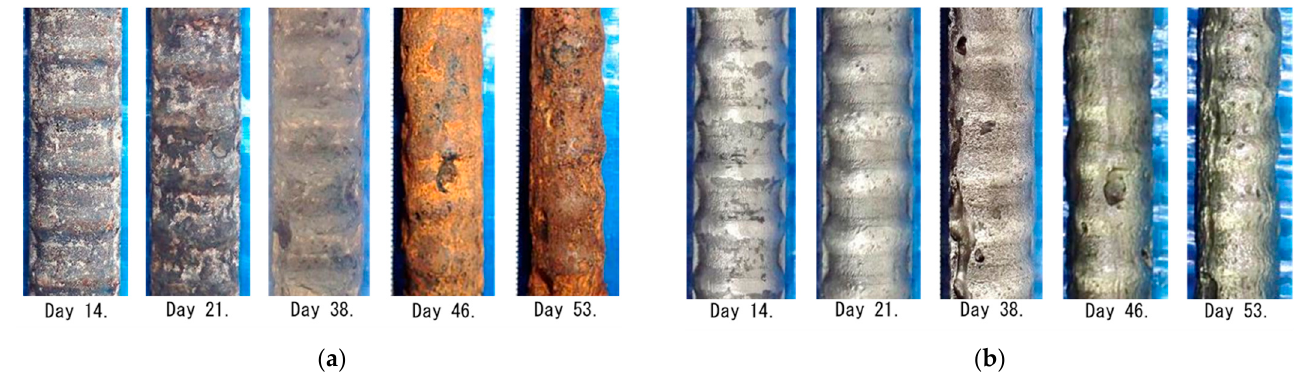
Figure 11. Photographs of corrosion situation of the rebar taken out from the test pieces: ( a ) before and; ( b ) after removing the rust from the rebar.